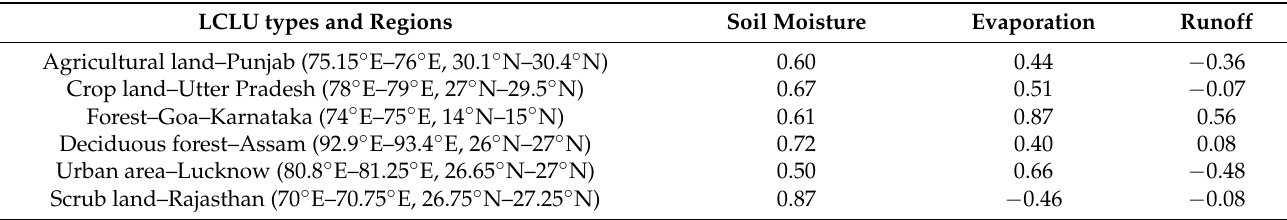
Table 3. Correlation between total precipitations with hydrological parameters. LCLU types and Regions Soil